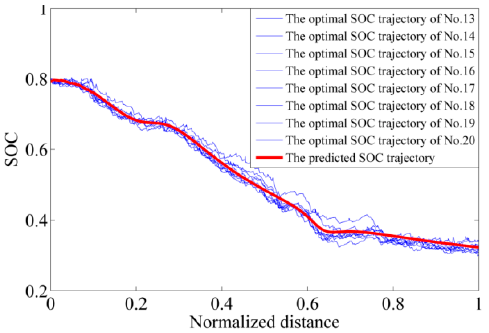
Figure 9. The comparison between the reference SOC and the optimal SOC trajectories.